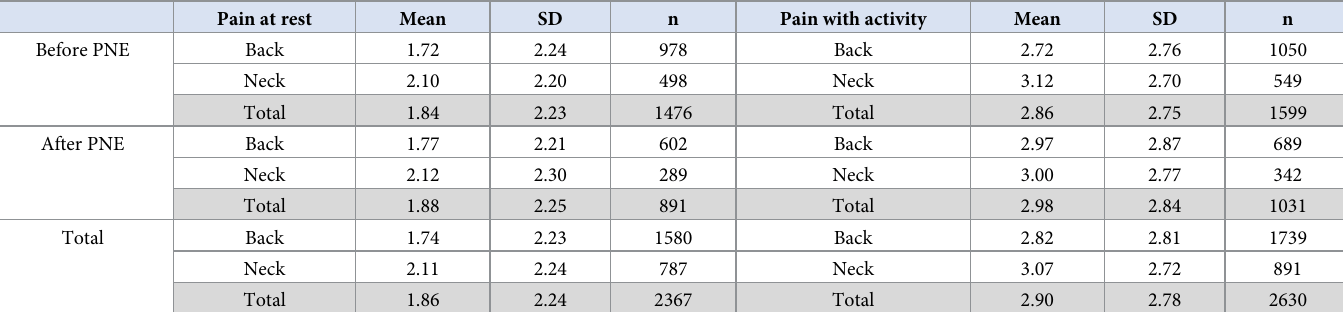
Table 3. Pain change (NPRS initial–NPRS discharge) for before and after PNE and by body region. Pain at rest Before PNE